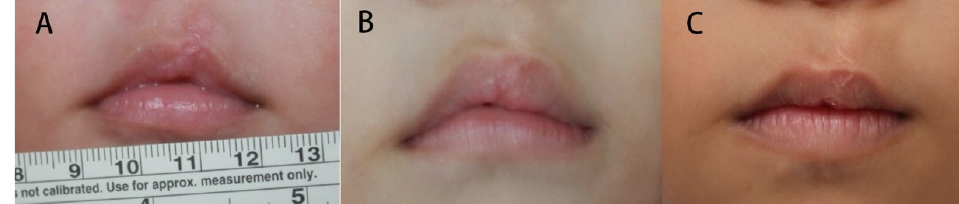
Figure 2. Vermillion change of an incomplete cleft lip. The vermillion was deficient compared with the normal side 1 month after surgery; however, it became excessive at 11 months and gradually subsided at 7 years old. ( A ) postoperative 1 month. ( B ) 11 months old. ( C ) 7 years old.